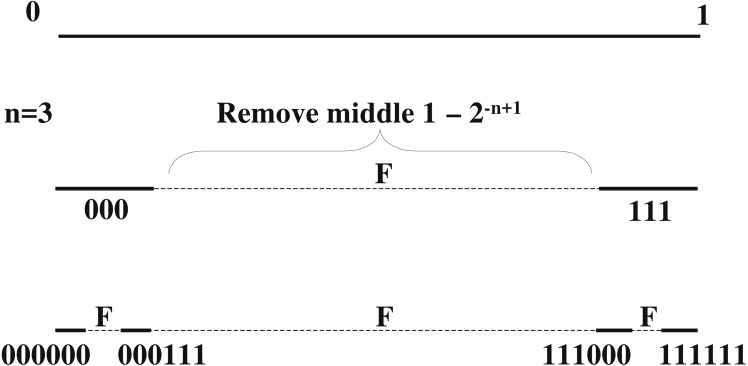
Repetition codes \documentclass[12pt]{minimal}
\usepackage{amsmath}
\usepackage{wasysym}
\usepackage{amsfonts}
\usepackage{amssymb}
\usepackage{amsbsy}
\usepackage{upgreek}
\usepackage{mathrsfs}
\setlength{\oddsidemargin}{-69pt}
\begin{document}
}{}${\mathcal{R}}_{n}$\end{document}Rn lie on a Cantor set: recursively remove the middle (1 − 2−n+1) fraction.As an example, \documentclass[12pt]{minimal}
\usepackage{amsmath}
\usepackage{wasysym}
\usepackage{amsfonts}
\usepackage{amssymb}
\usepackage{amsbsy}
\usepackage{upgreek}
\usepackage{mathrsfs}
\setlength{\oddsidemargin}{-69pt}
\begin{document}
}{}${\mathcal{R}}_{3}$\end{document}R3 is depicted above. The box-counting dimension of the Cantor set is \documentclass[12pt]{minimal}
\usepackage{amsmath}
\usepackage{wasysym}
\usepackage{amsfonts}
\usepackage{amssymb}
\usepackage{amsbsy}
\usepackage{upgreek}
\usepackage{mathrsfs}
\setlength{\oddsidemargin}{-69pt}
\begin{document}
}{}$D= \frac{1}{n} $\end{document}D=1n. This is equal to the rate of the code.